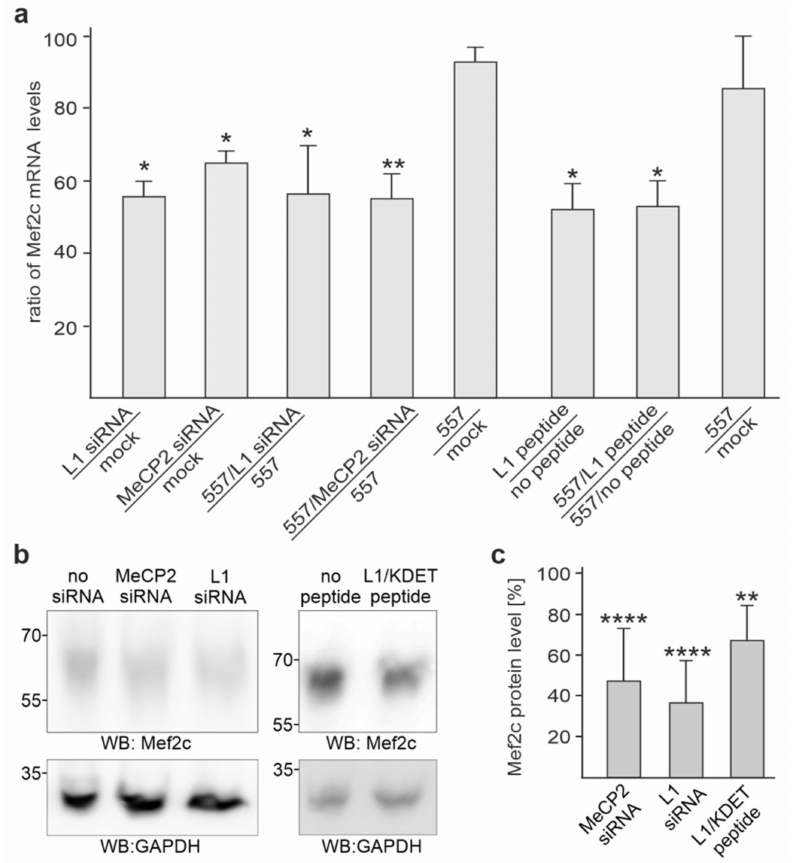
Figure 6. MeCP2 and L1 regulate Mef2c expression in cortical neurons. ( a ) Cortical neurons were mock-transfected or transfected with MeCP2 siRNA or L1 siRNA, or they were treated without or with the cell-penetrating tat-L1/KDET peptide. Neurons were then treated without or with L1 antibody 557 and subjected to RNA isolation and RT-qPCR. The Mef2c mRNA levels were normalized to the actin mRNA levels. Mean values + SD from three independent experiments with triplicates are shown for normalized Mef2c mRNA levels in neurons after transfection with siRNA or treatment with the tat-L1/KDET peptide relative to the levels in mock-transfected neurons (* p < 0.05; ** p < 0.01; one-way ANOVA with Dunn’s multiple comparison test). ( b ) Lysates from cortical neurons treated without or with MeCP2 siRNA, L1 siRNA, or tat-L1/KDET peptide were subjected to Western blot analysis with Mef2c antibody or GAPDH antibody to control loading. ( c ) Mean values + SD from four experiments are shown for Mef2c protein levels relative to control levels (values without treatment set to 100%) (** p < 0.01, **** p < 0.001; one-way ANOVA with Bonferroni’s multiple comparison